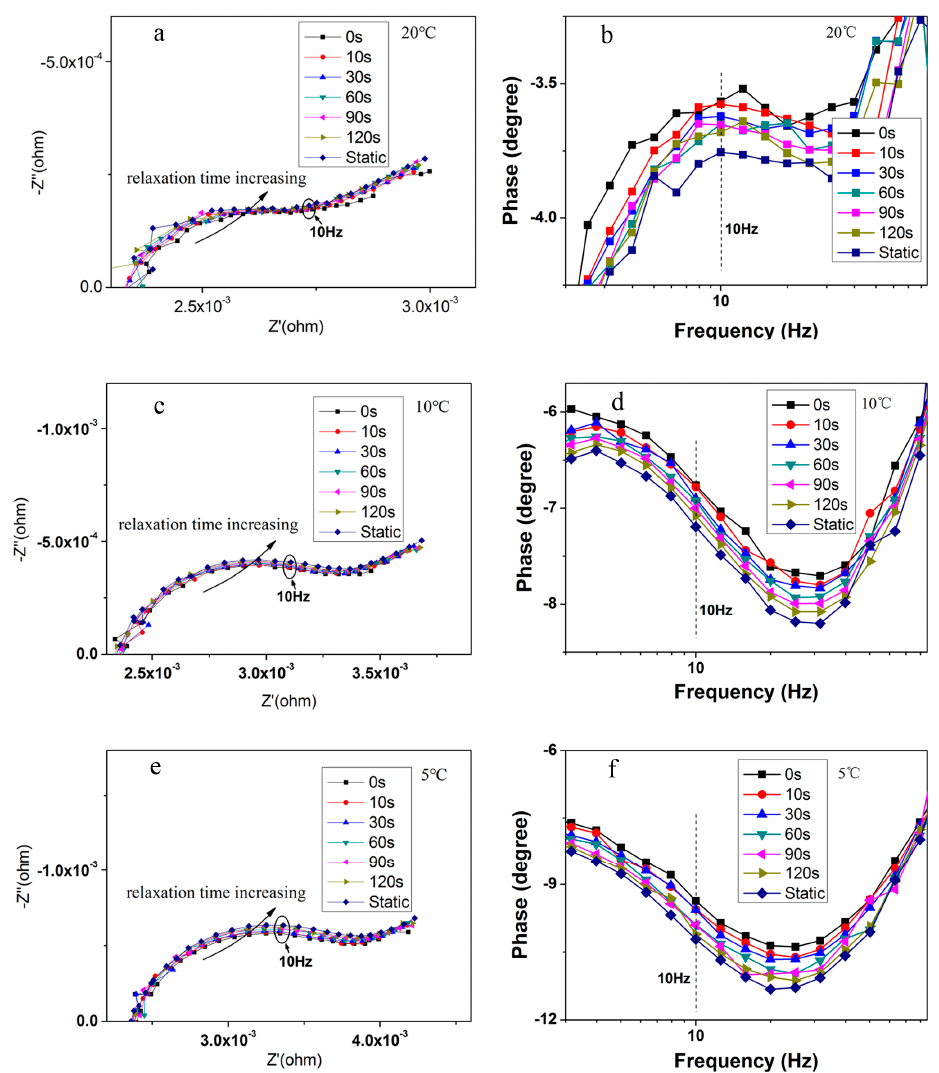
Figure 6. Impedance results at various relaxation time. ( a ) EIS results at 20 °C; ( b ) enlarged phase shift results at 20 °C; ( c ) EIS results at 10 °C; ( d ) enlarged phase shift results at 10 °C; ( e ) EIS results at 5 °C; and ( f ) enlarged phase shift results at 5 °C.